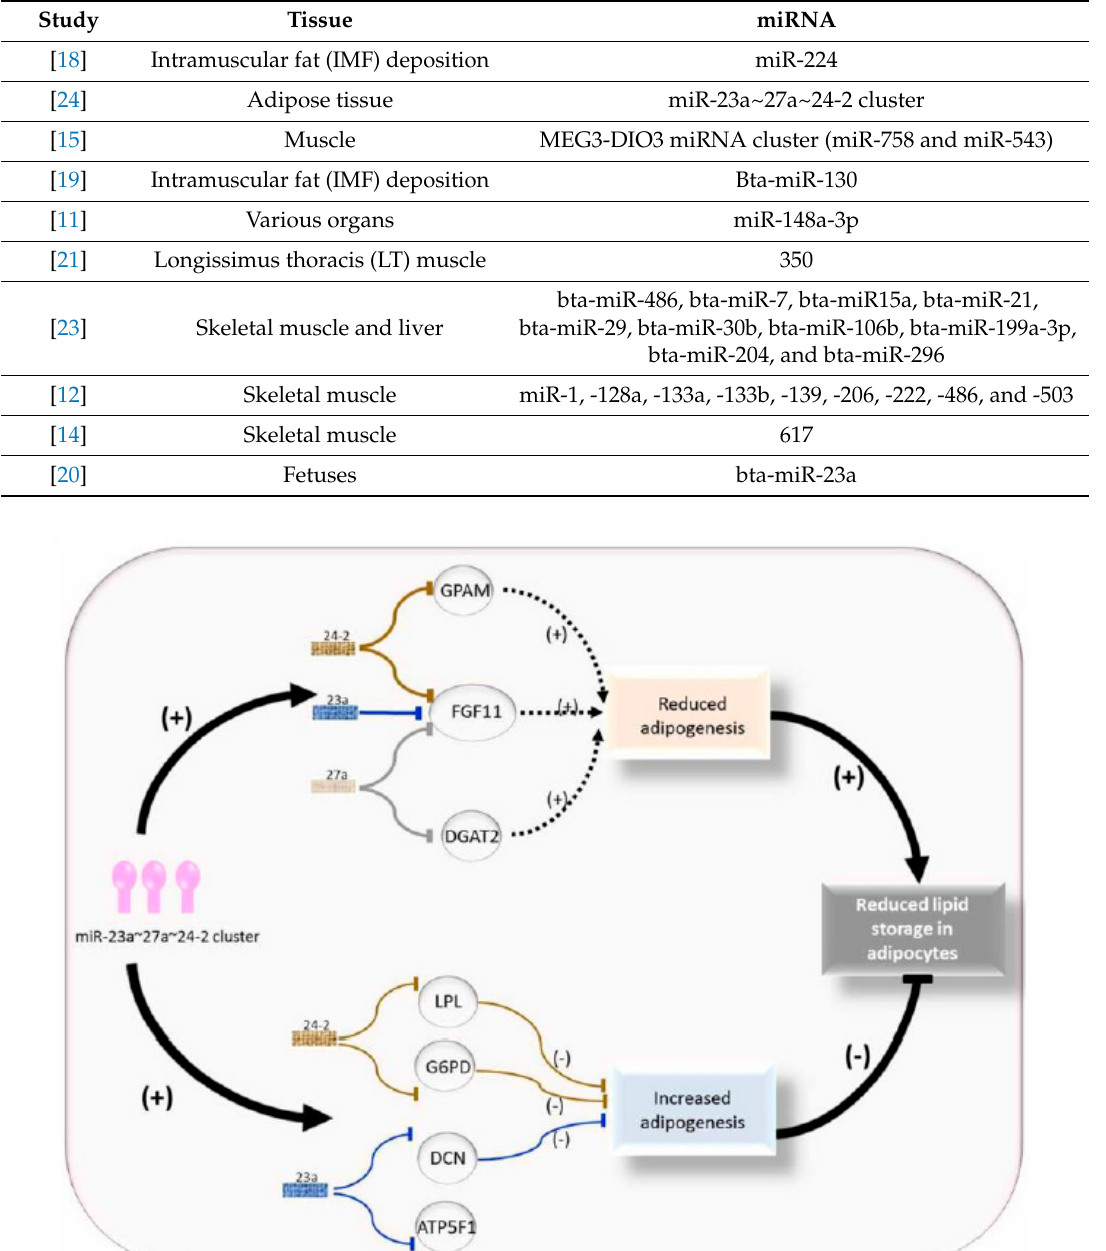
Table 1. The overview of microRNAs (miRNAs) associated with muscle functions.